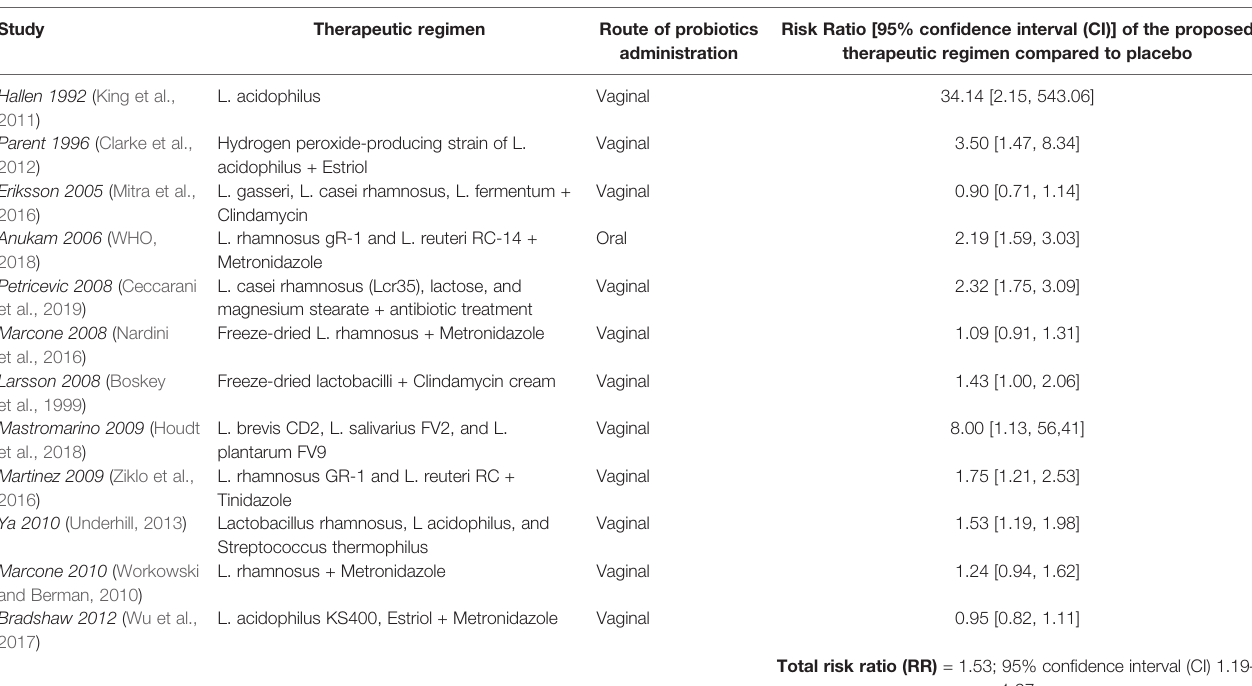
TABLE 2 | Effects of probiotics supplementation in non-pregnant women affected by bacterial vaginosis. List of research studies included in the Huang metanalysis on the usage of probiotics alone or as adjuvants against bacterial vaginosis (patient cohort = 1304 women)